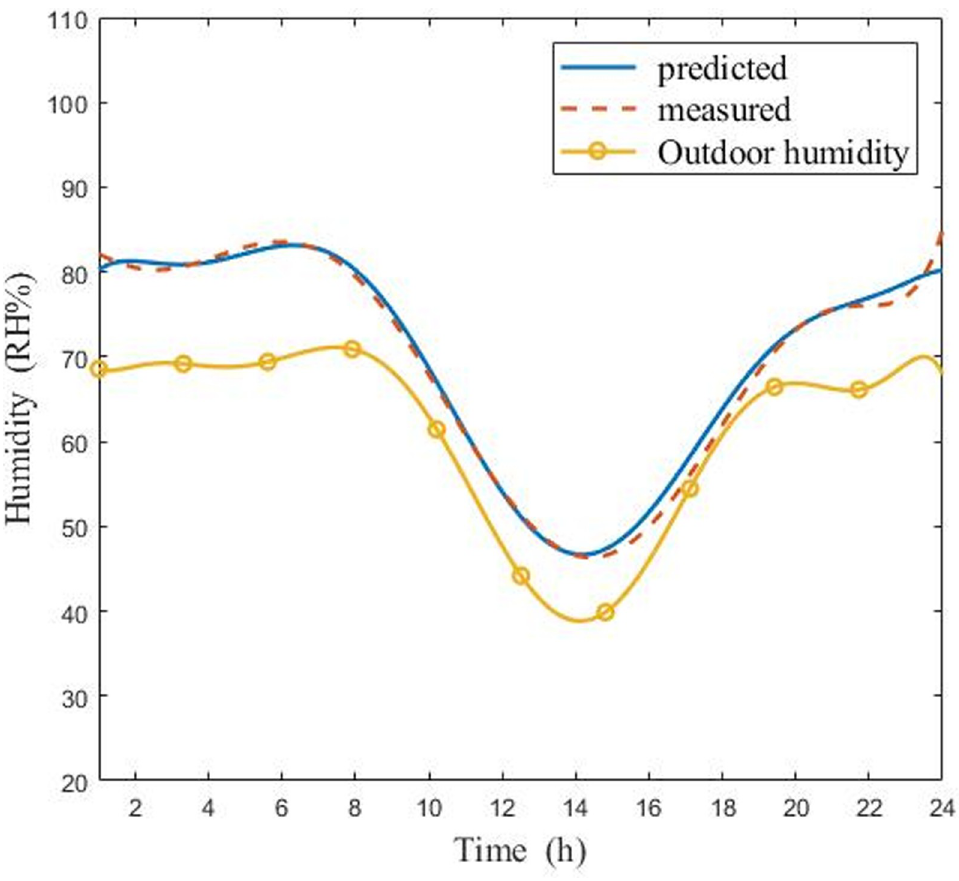
Fig 12. Comparisons of measured and predicted air humidity in CSG in cloudy day (6:00 in the morning ~ 5:00 the next day).